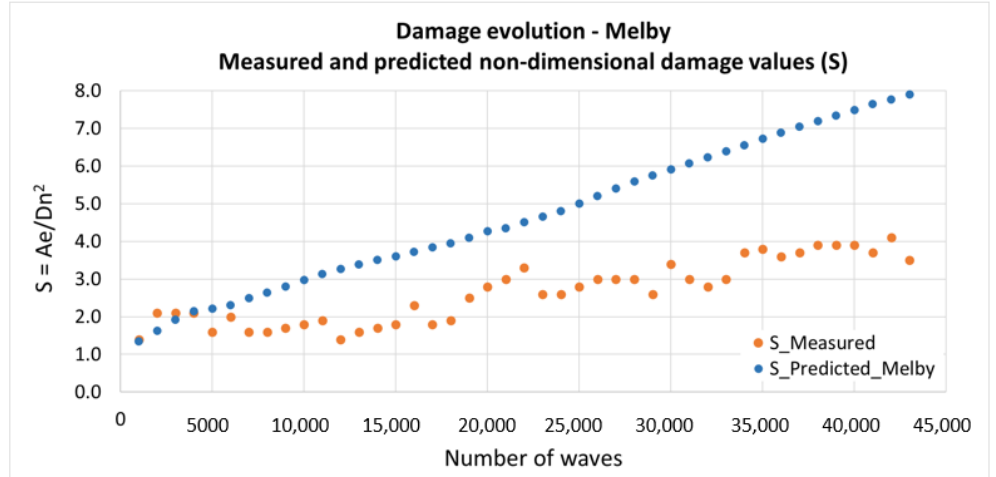
Figure 7. Damage evolution for measured and predicted values of the non-dimensional damage parameter (S).